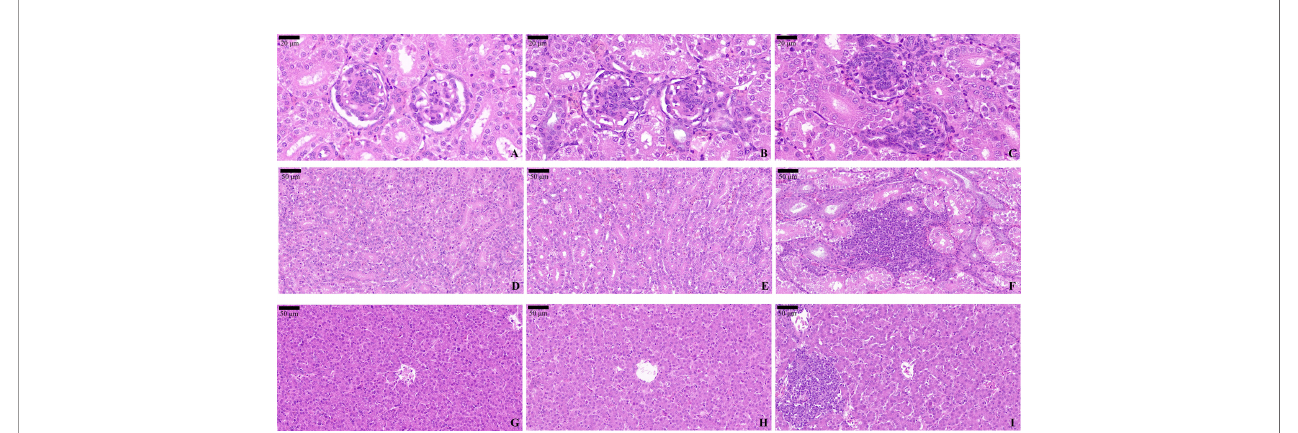
FIGURE 8 | H&E staining of the pullets ’ kidney and liver after 42-day trial. Groups A, B, and C are the control group, the pair-feeding group, and the OTA+AFB1 group, respectively. (A) Glomeruli of Group A, ×90. (B) Glomeruli of Group B, ×90. (C) Glomeruli of Group C, ×90. (D) Renal tubules of Group A, ×40. (E) Renal tubules of Group B, ×40. (F) Renal tubules of Group C, ×40. (G) Liver of Group A, ×40. (H) Liver of Group B, ×40. (I) Liver of Group C, ×40. OTA, ochratoxin A; AFB1, a fl atoxin